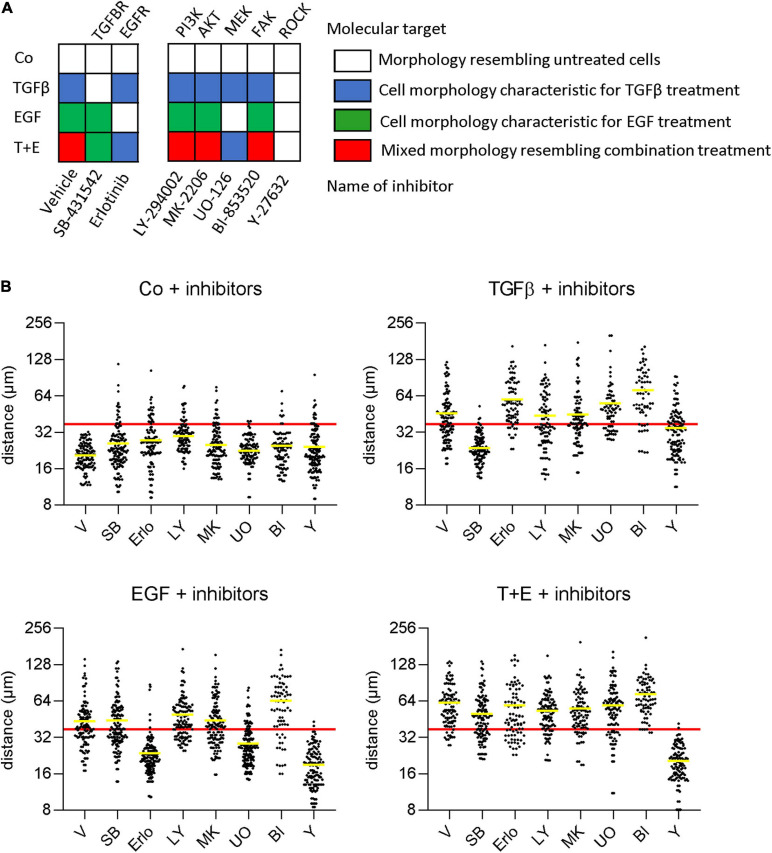
EGF but not TGFβ depends on MAPK signaling for stimulation of migration and morphological alterations. (A) Cells were pre-treated with the indicated inhibitors or vehicle 1 h before treatment with TGFβ, EGF, or both (T + E) and images were recorded after 48 h. Growth factor-specific alterations in cell morphologies (as described in Figure 2A) are indicated by the respective colors. (B) Cells were treated as above with SB-431542 (SB), erlotinib (Erlo), LY-294002 (LY), MK-2206 (MK), U0126 (U0), BI-853520 (BI), Y-27632 (Y), or vehicle (V) plus the respective growth factors, and distance to nearest neighbors was assessed using Image J. Data are shown as scatter plots and mean (yellow line) of >100 individual cells. The mean diameter of a non-treated cell (37 μm) is shown as a red horizontal line and was chosen as cut-off for the mean to describe cell scattering (Bakiri et al., 2015; Selvaraj et al., 2015; Hyakusoku et al., 2016).